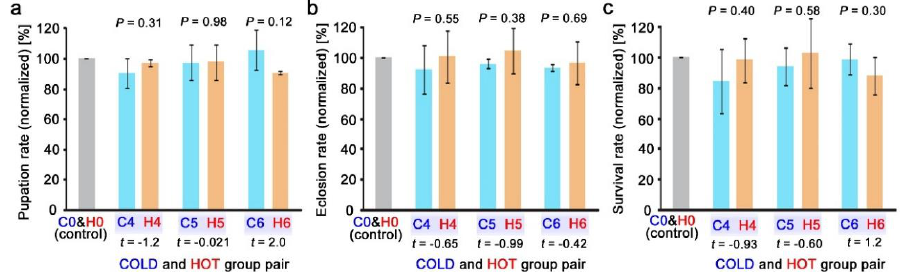
Figure 8. Comparisons of the effects of nonradioactive and radioactive caesium chloride. C0 and H0 were set at 100%, and the normalised values were compared between the cold ( n = 3) and hot ( n = 3) results. P -values were obtained using a Student’s t -tests ( df = 4 in all combinations). ( a ) The pupation rate (%). ( b ) The eclosion rate (%). ( c ) The survival rate (%).